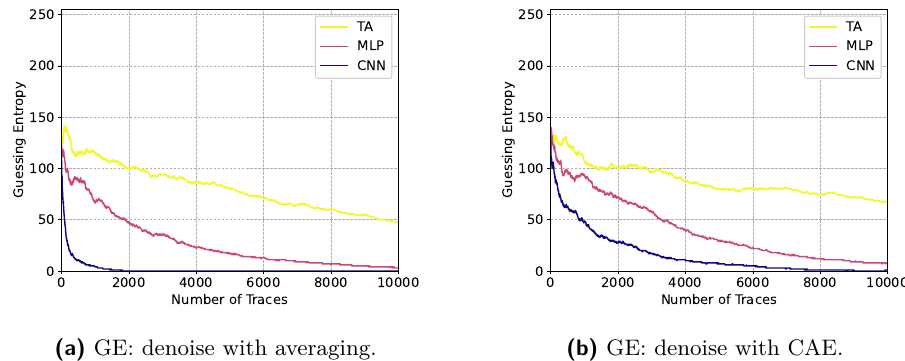
Figure 2: Guessing entropy: denoising Gaussian noise with averaging (a) and CAE (b).